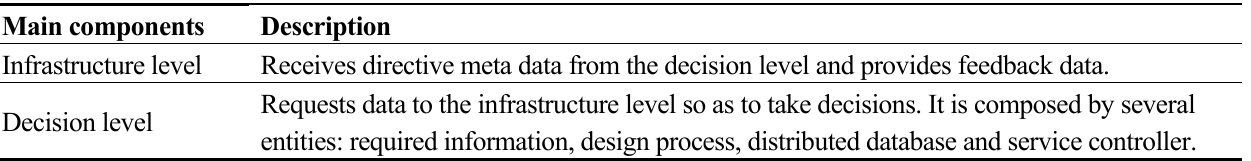
Table 9. Description of Self-Organizing Smart Grid Services main components.